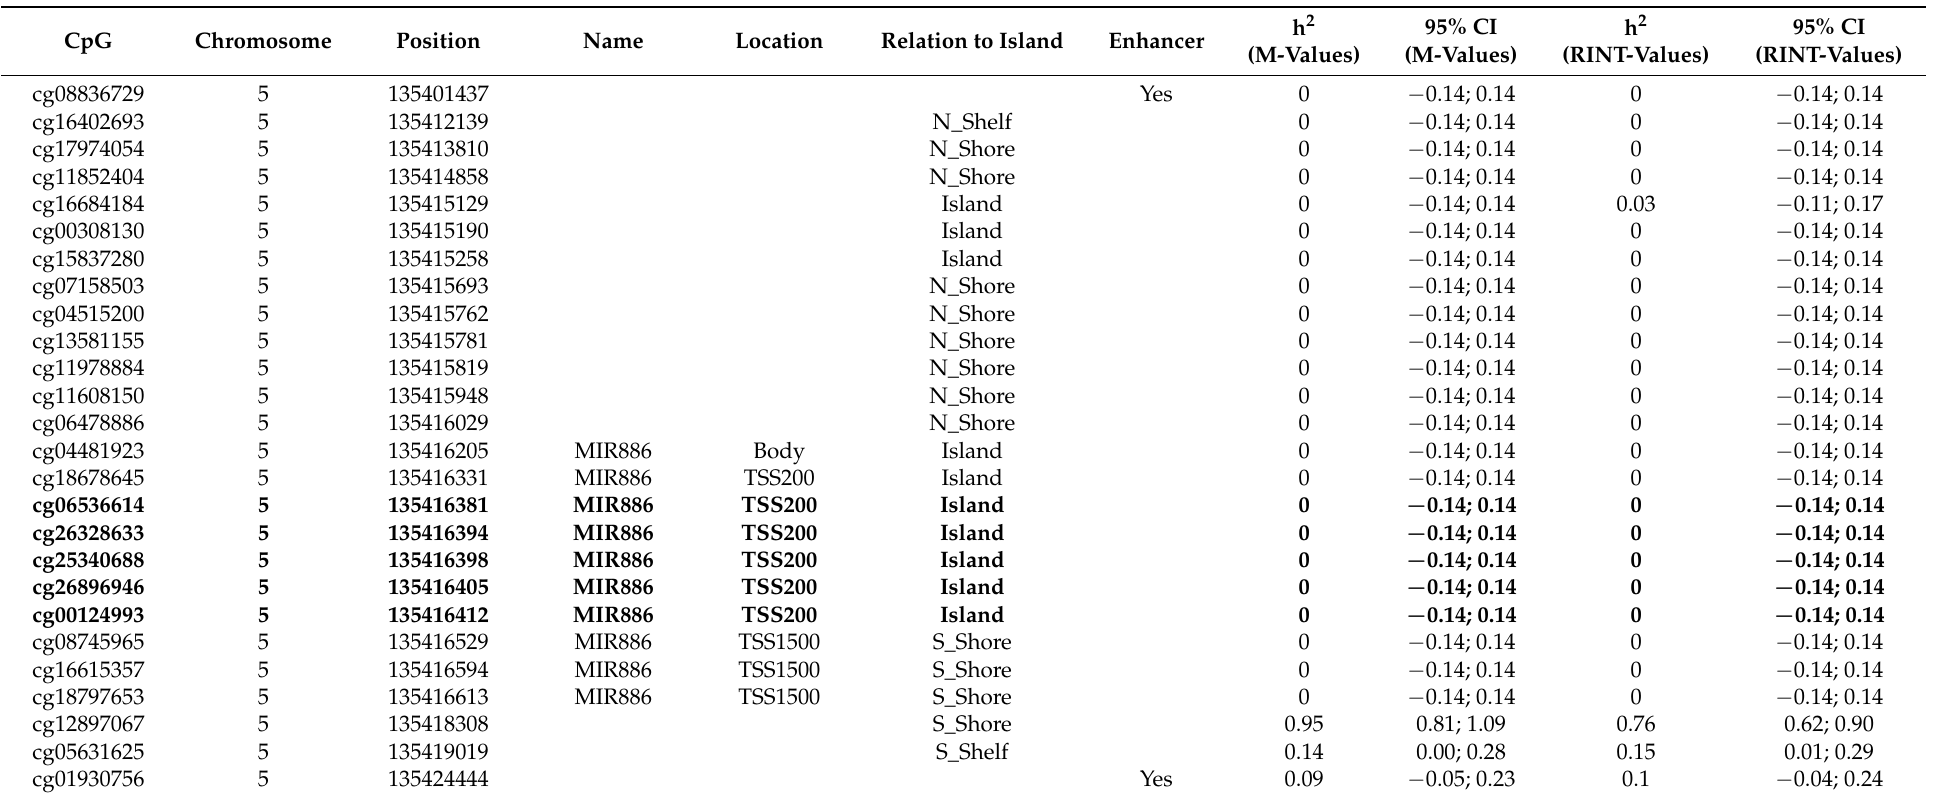
Table 3. SNP-based heritability (h 2 ) for 26 CpGs in the VTRNA2-1 ( MIR886 in the Illumina HM450 annotation file) region, for M values and RINT values.